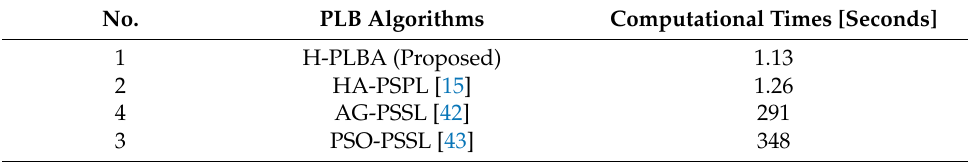
Table 6. The performance of the PLB algorithms based computational